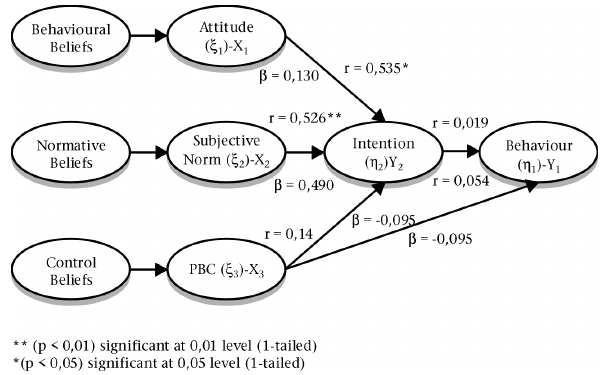
Figure 1: TPB model